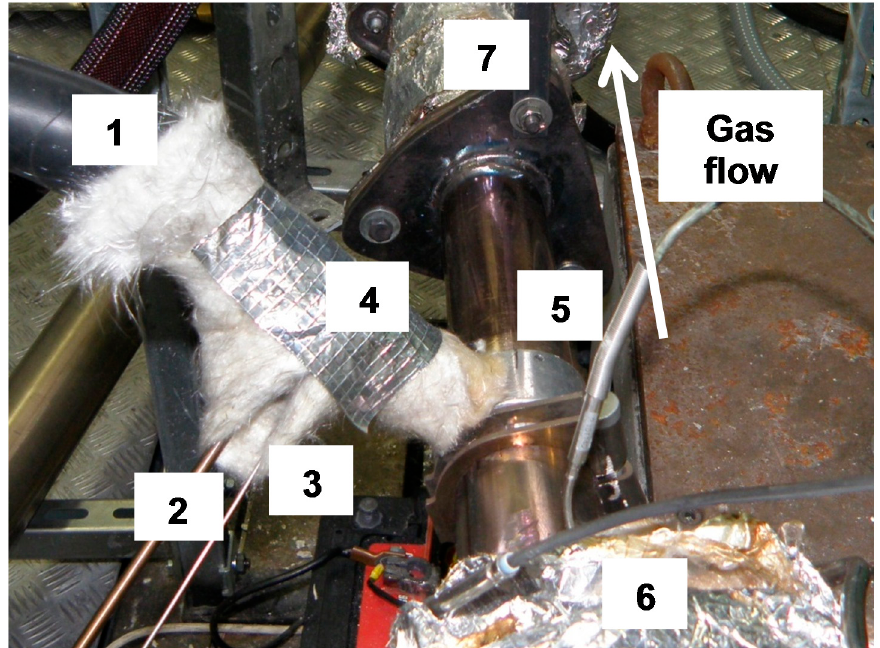
Figure 7. Gaseous urea dosing system: 1—heating chamber, 2—urea pressure port, 3—urea temperature port, 4—insulated tube, 5—mixing element, 6—DPF filter, 7—SCR catalyst.